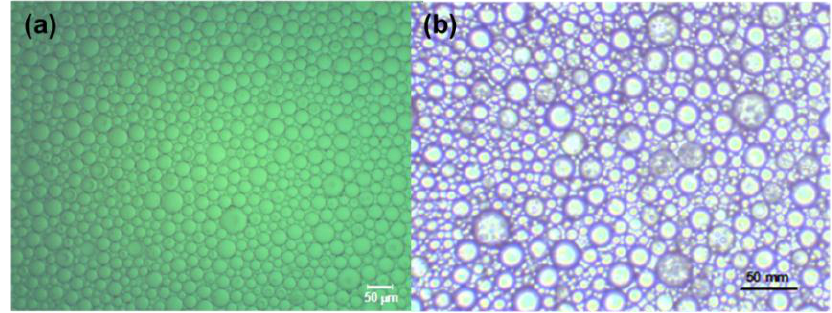
Figure 1. Micrograph of emulsions stabilized with ( a ) surfactant ( f = 10 Hz, a = 6 mm, J = 50 LMH); and ( b ) metal organic frameworks (MOF) particles ( f = 18 Hz, a = 20 mm, J = 72 LMH). LMH: liter per meter square per hour.